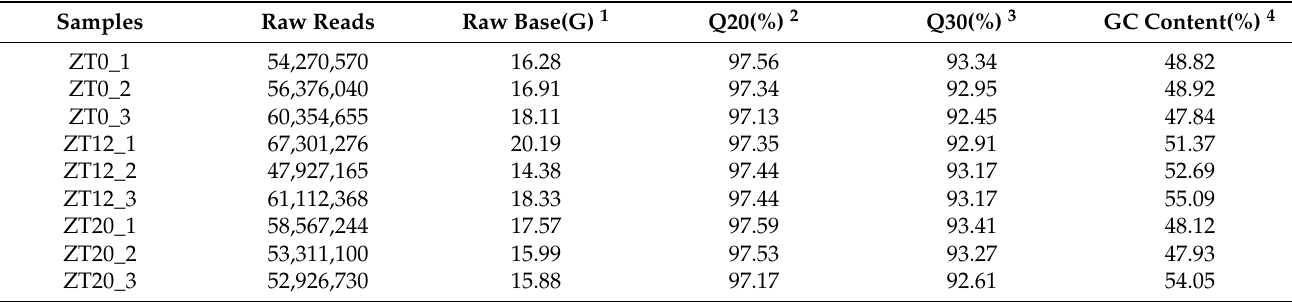
Table 1. Data summary of RNA-seq in granulosa cell of